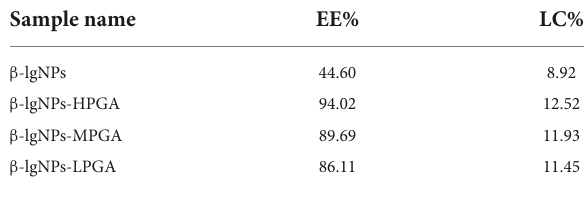
TABLE 2 Entrapment efficiency (EE) and loading capacity (LC) of Cur in PGA- β -lgNPs complexes.